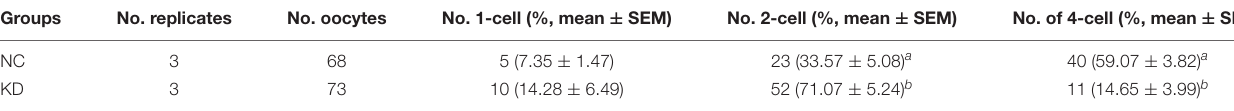
TABLE 4 | SIN3A depletion results in two-cell arrest in porcine early embryos. Groups